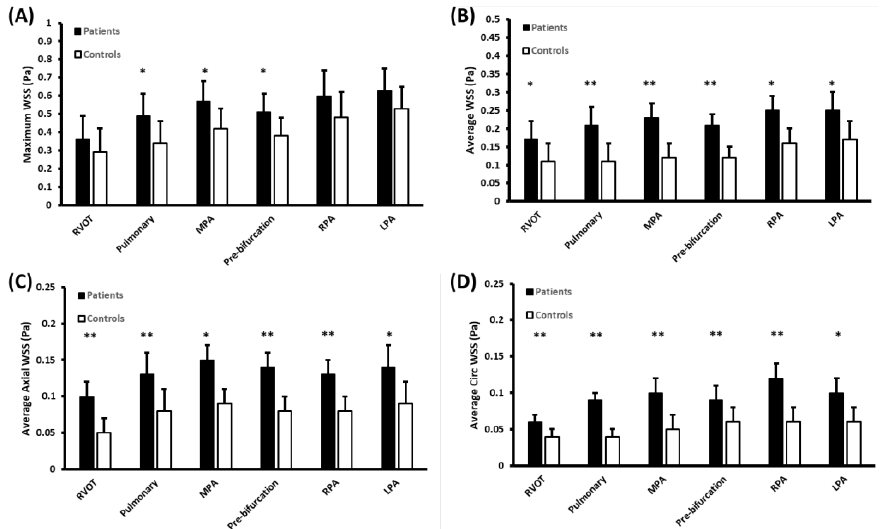
Figure 7. Wall shear stress assessment along the pulmonary artery. Right ventricular outflow tract (RVOT), pulmonary valve, main pulmonary artery (MPA), pre-bifurcation, right pulmonary artery (RPA), and left pulmonary artery (LPA). Panel ( A ) shows the assessment of maximum wall shear stress (WSS). Panel ( B ) shows the average WSS assessment. Panel ( C ) shows the assessment of average axial WSS and Panel ( D ) shows the average circumferential (Circ) WSS. * indicates p - value ≤ 0.05 between rTOF patients and controls. ** indicates p - value ≤ 0.001 between rTOF patients and controls. PD was consistently higher in the rTOF patients versus the controls ( p < 0.05) along the PA, Figure 8. Maximum PD differences were more apparent in the pulmonary valve,